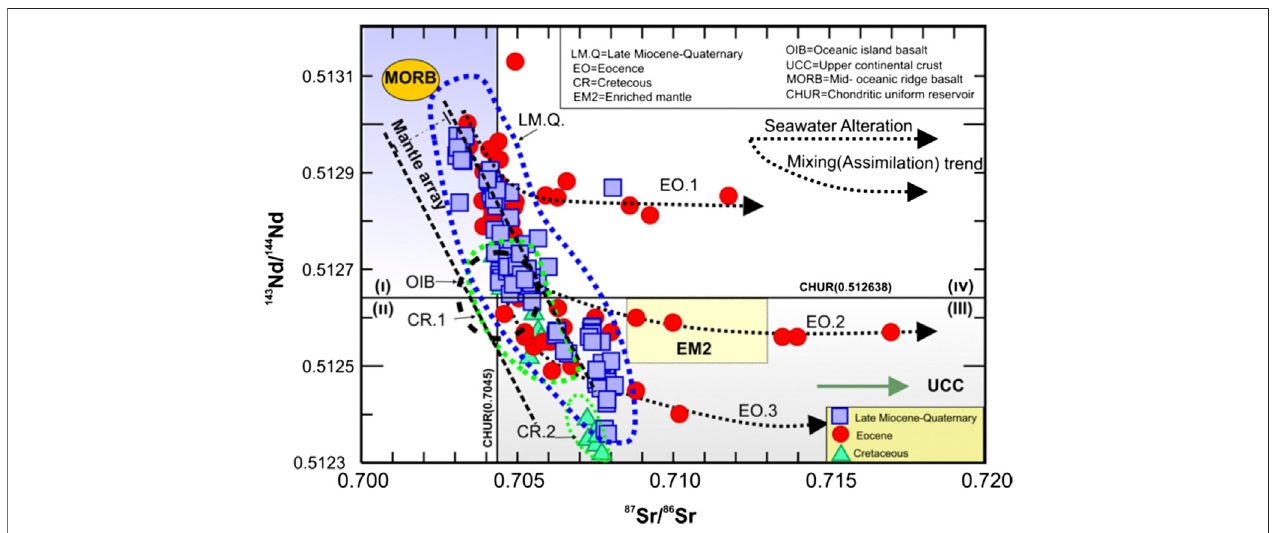
FIGURE11 | Distributionof 87 Sr/ 86 Sr vs. 143 Nd/ 144 Nd ratios shows thatthe main samplesextend along mantle arrays. TheCretaceous samplesare plotted in two different fi elds, CR.1 and CR.2. The Eocene rocks show three different patterns — EO1-EO3 — which con fi rms some seawater alteration and continental-crustal mixing. Upper Miocene-Quaternary samples plot in mantle arrays with less variation. For the sources of the data, see Supplementary S2 .